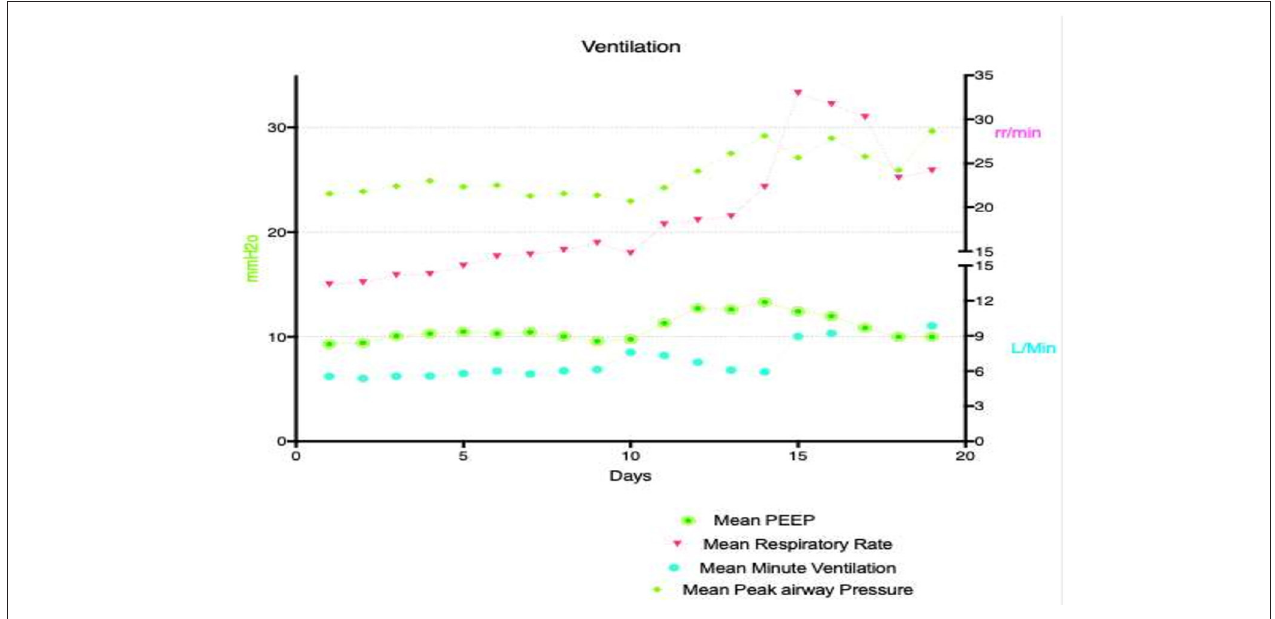
FIGURE 6 | Mechanical ventilation parameters for the duration of ECMO support.